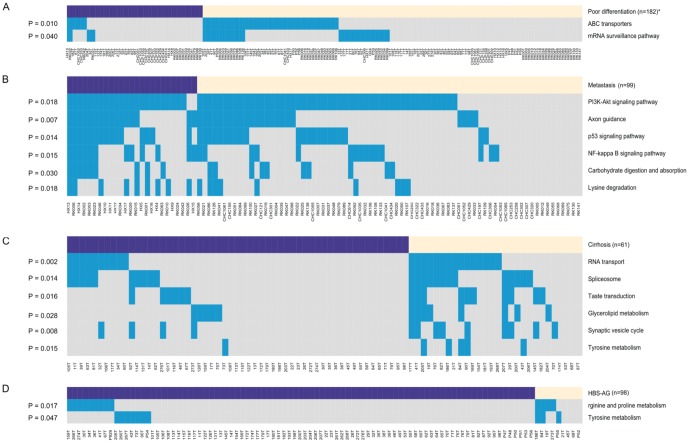
Overview of pathway mutations and major associated clinical features, including A, Cell differentiation; B, Metastasis; C, Cirrhosis; and D, HBS-AG.The lower heatmap shows pathways (rows) and tumors (columns) with mutations (blue). The purple (or yellow) boxes above the heatmap represent poor differentiation (or good differentiation), metastasis (or non-metastasis), cirrhosis (or non-cirrhosis) and HBS-AG positive (or HBS-AG negative), respectively. The P-value of each pathway is indicated to the left. *n is the number of HCC patients with available clinical information.